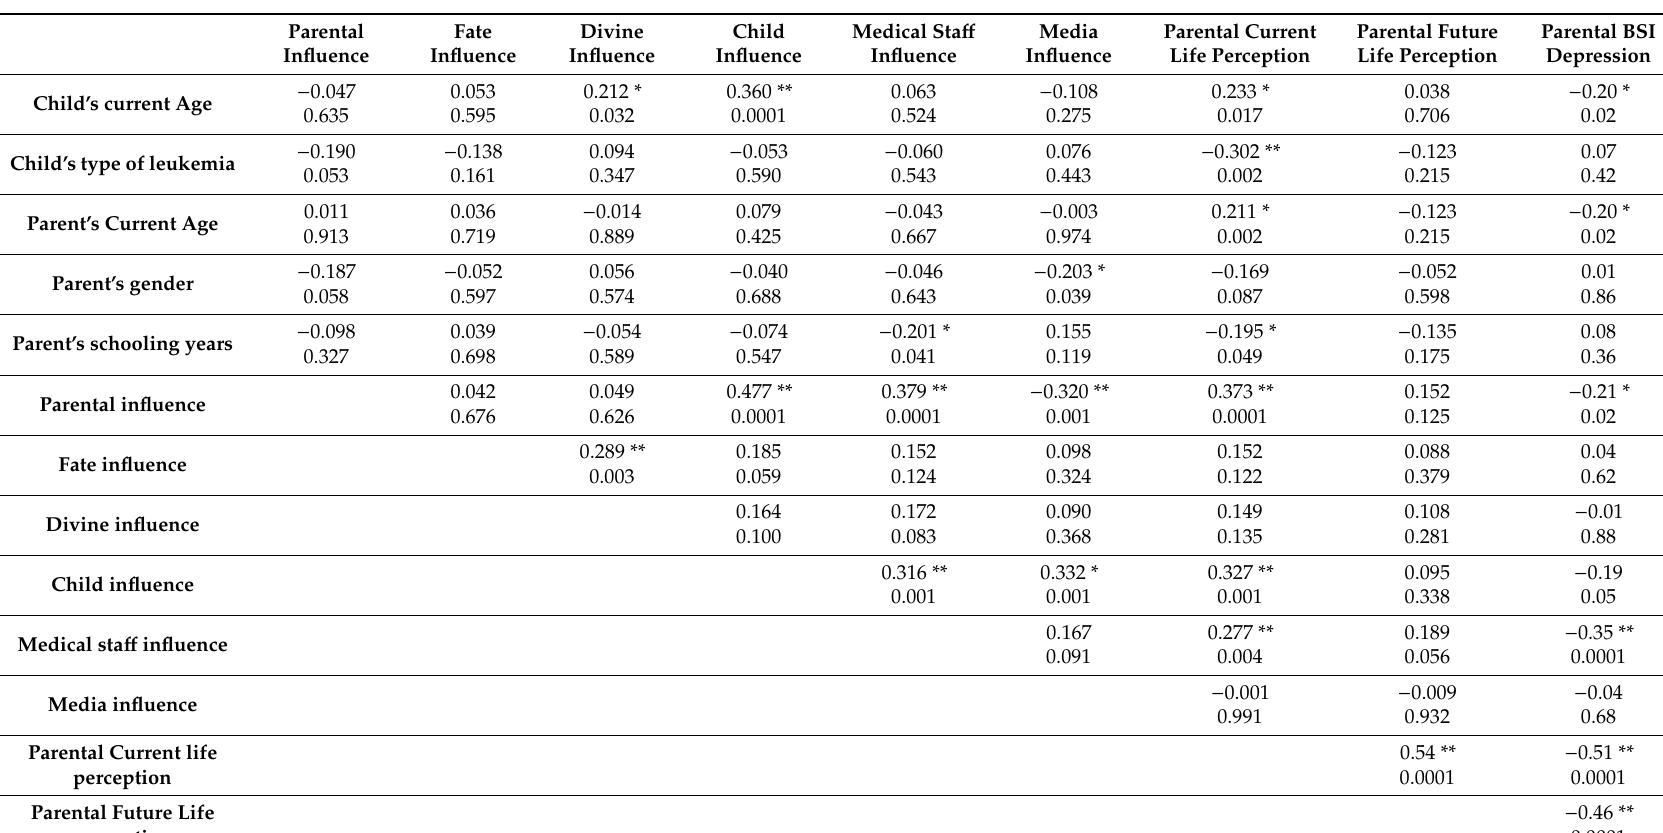
Table 3. Pearson’s correlations between Parental Health Locus of Control, Life Perceptions, Depressive symptomatology, Socio-Demographic and Illness